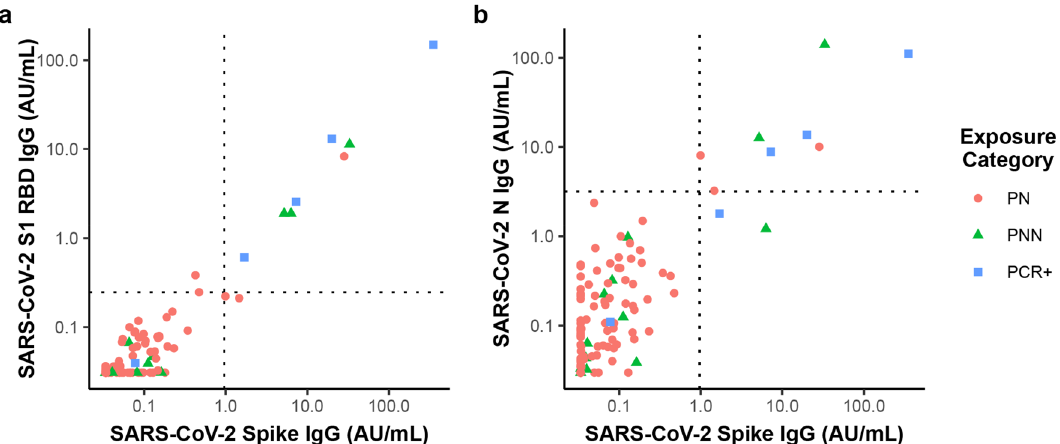
Figure 4. Correlation in salivary IgG levels for CoV-2 spike, RBD, and N antigens. Levels of salivary IgG antibodies to the full length spike protein are highly correlated with IgG antibody levels for ( a ) RBD of the spike protein and ( b ) N antigen. Dashed lines indicate the selected classification thresholds set at the 98th percentile of saliva from PN donors who report no COVID-19 diagnosis, recent symptoms, or household exposure to